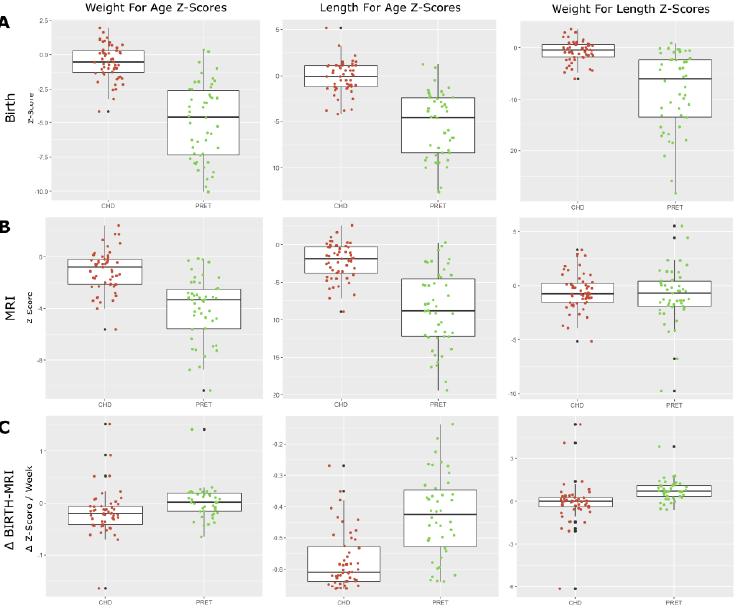
Figure 1. Growth parameter z-scores at ( A ) birth, ( B ) time of MRI, and ( C ) change between birth and time of MRI. WAZ, LAZ, and WLZ at birth shows the expected lower z-scores for preterm-born neonates. CHD neonates at birth show slightly below average z-scores. At the time of MRI, we start to see preterm-born neonates approach normative values. The changes in WAZ, LAZ, and WLZ from birth to MRI show a consistent decrease in CHD neonates, while preterm-born neonates show an increase in weight for age and weight for length, and a decrease in length for age. Supplemental Figure S2 shows the preterm group’s PMA adjusted cerebel lar volumes, mean 699.3 (+/ − 3512.3) mm 3 , compared with the term controls, mean 457.8 (+/ − 2064.2) mm 3 and the CHD group, mean −683.8 (+/−2428.0) mm 3 . The preterm cerebellar volumes were significantly higher than the CHD group ( p < 0.008), and the CHD group weight from birth to time of MRI showed a moderately strong correlation with cerebellar volume at the time of MRI (r= 0.437, p < 0.002) in the preterms, but not the in the term- born CHD neonates (r = 0.205, p < 0.116), significant at p < 0.000 (Figure 2). However, when normalized to Z-scores, no significantly strong correlation was observed. Changes in both birth length and occipital-frontal circumference (from birth to time of MRI) showed no significant correlation with cerebellar volume at the time of MRI in either cohort.